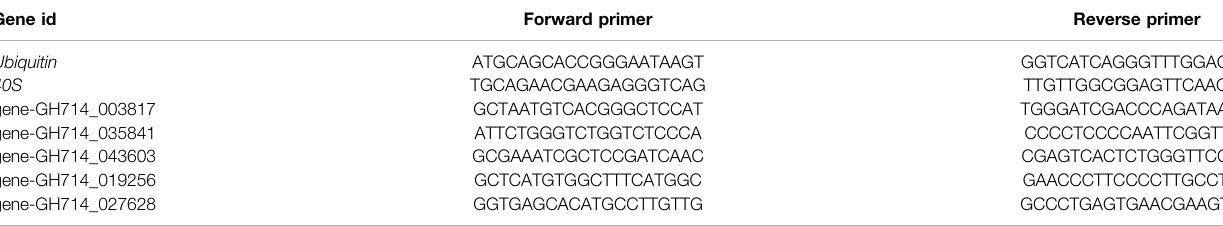
TABLE 1 | Oligonucleotide primers used for RT-qPCR in this study. Gene id